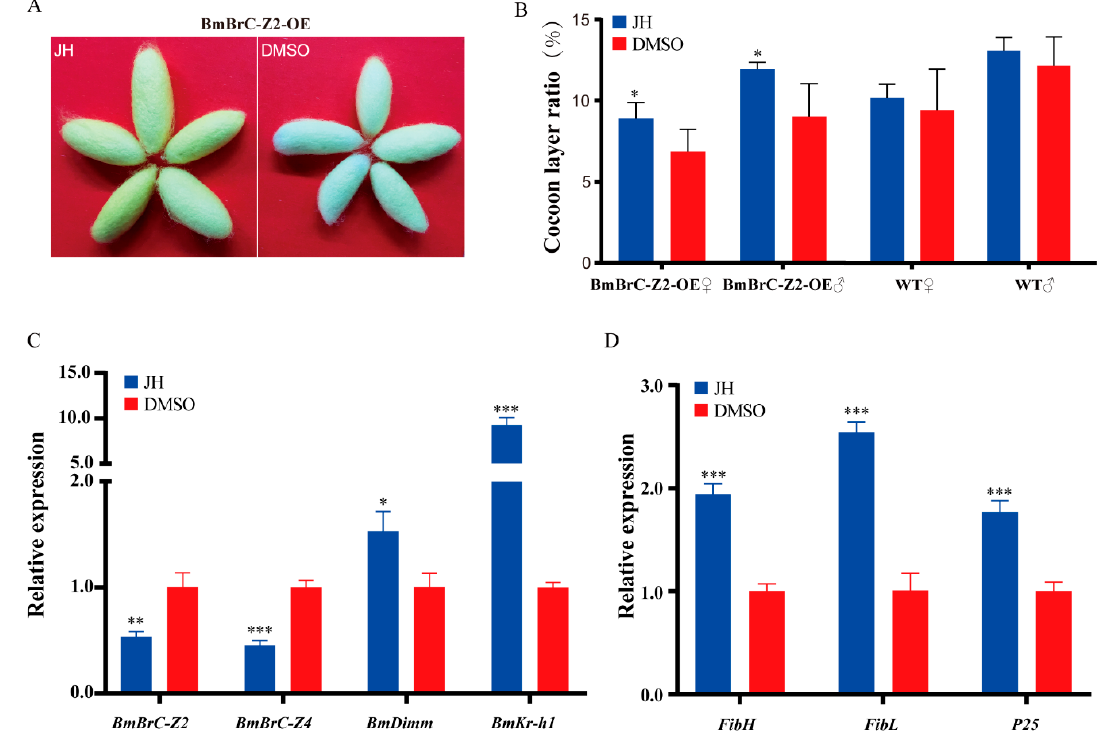
Figure 4. Juvenile hormone (JH) analog rescues the cocoon phenotype of the transgenic overexpression line. ( A , B ) Phenotype observation and cocoon layer ratio statistics (n = 10). Treatments of DMSO was used as the control; ( C , D ) relative mRNA levels of genes were investigated by qRT-PCR after treatment of JH analog in the transgenic overexpressing BmBrC-Z2 line. Including: BmBrC-Z2, BmBrC-Z4, BmDimm , BmKr-h1 , FibH, FibL, P25 . RPL3 was used as the control. *— p < 0.05, **— p < 0.01, ***— p < 0.001); WT—wild type; OE—overexpression.